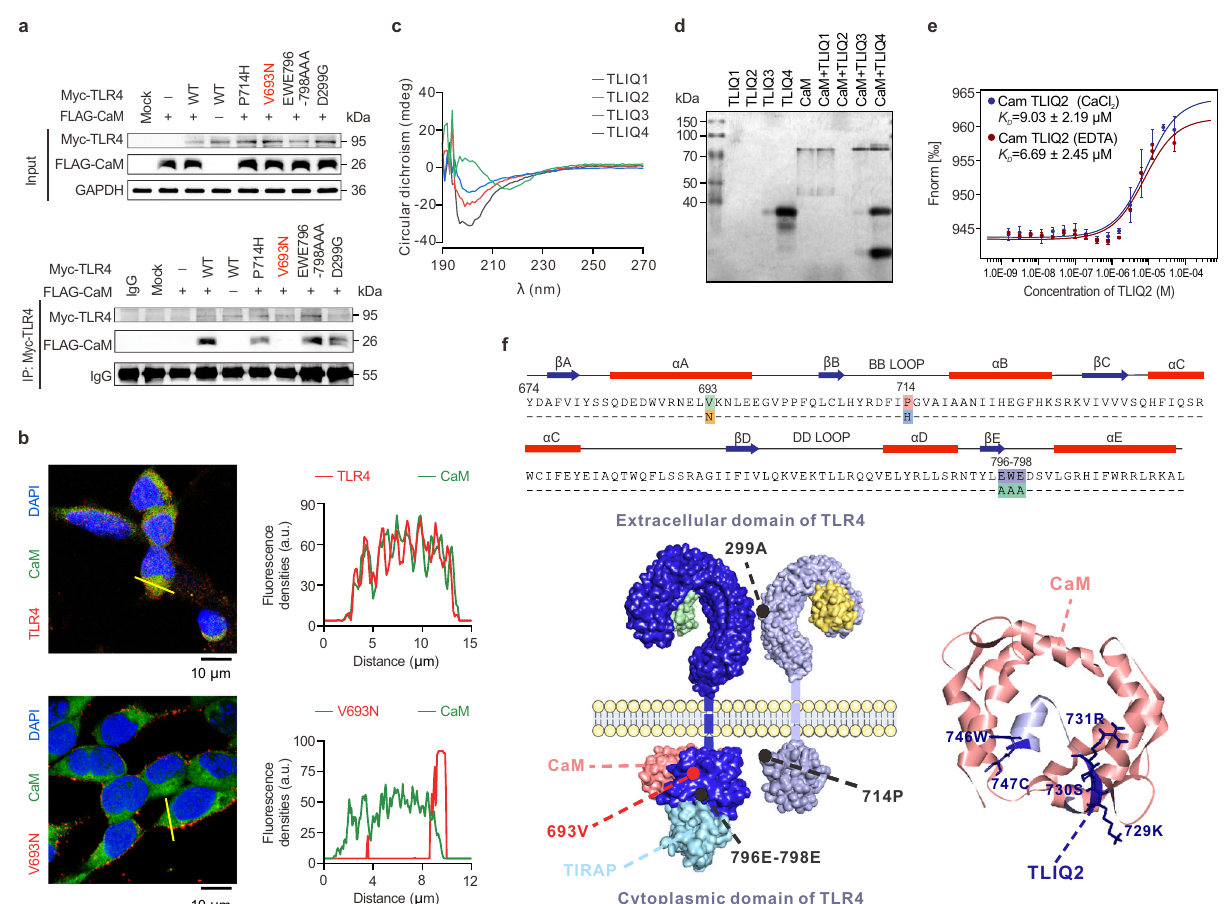
Fig. 6 | CaMbinds to both the Poc site and theatypicalIQmotif ofTLR4. a The interacted domain of TLR4 (Myc-tagged) with CaM (FLAG-tagged) in co- transfected HEK293T cells measured using Co-IP ( n =2 biological independent experiments). b Representative immuno fl uorescent photomicrographs (left panel) and traces of fl uorescence intensity spatial pro fi les (right panel) of TLR4 (Myc-tagged) with CaM (FLAG-tagged) localization in co-transfected HEK293T cells ( n =6 images from 3 biological independent experiments). c The CDspectroscopiesofthe synthesizedpeptides. d TheinteractionofCaMwiththe